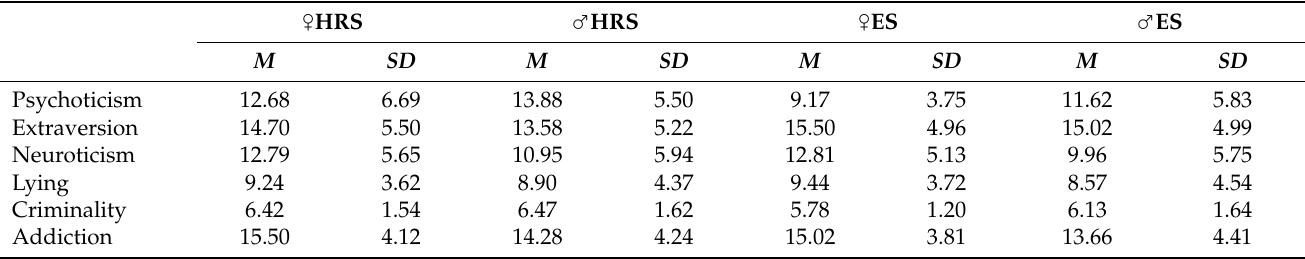
Table 2. Descriptive statistics of personality